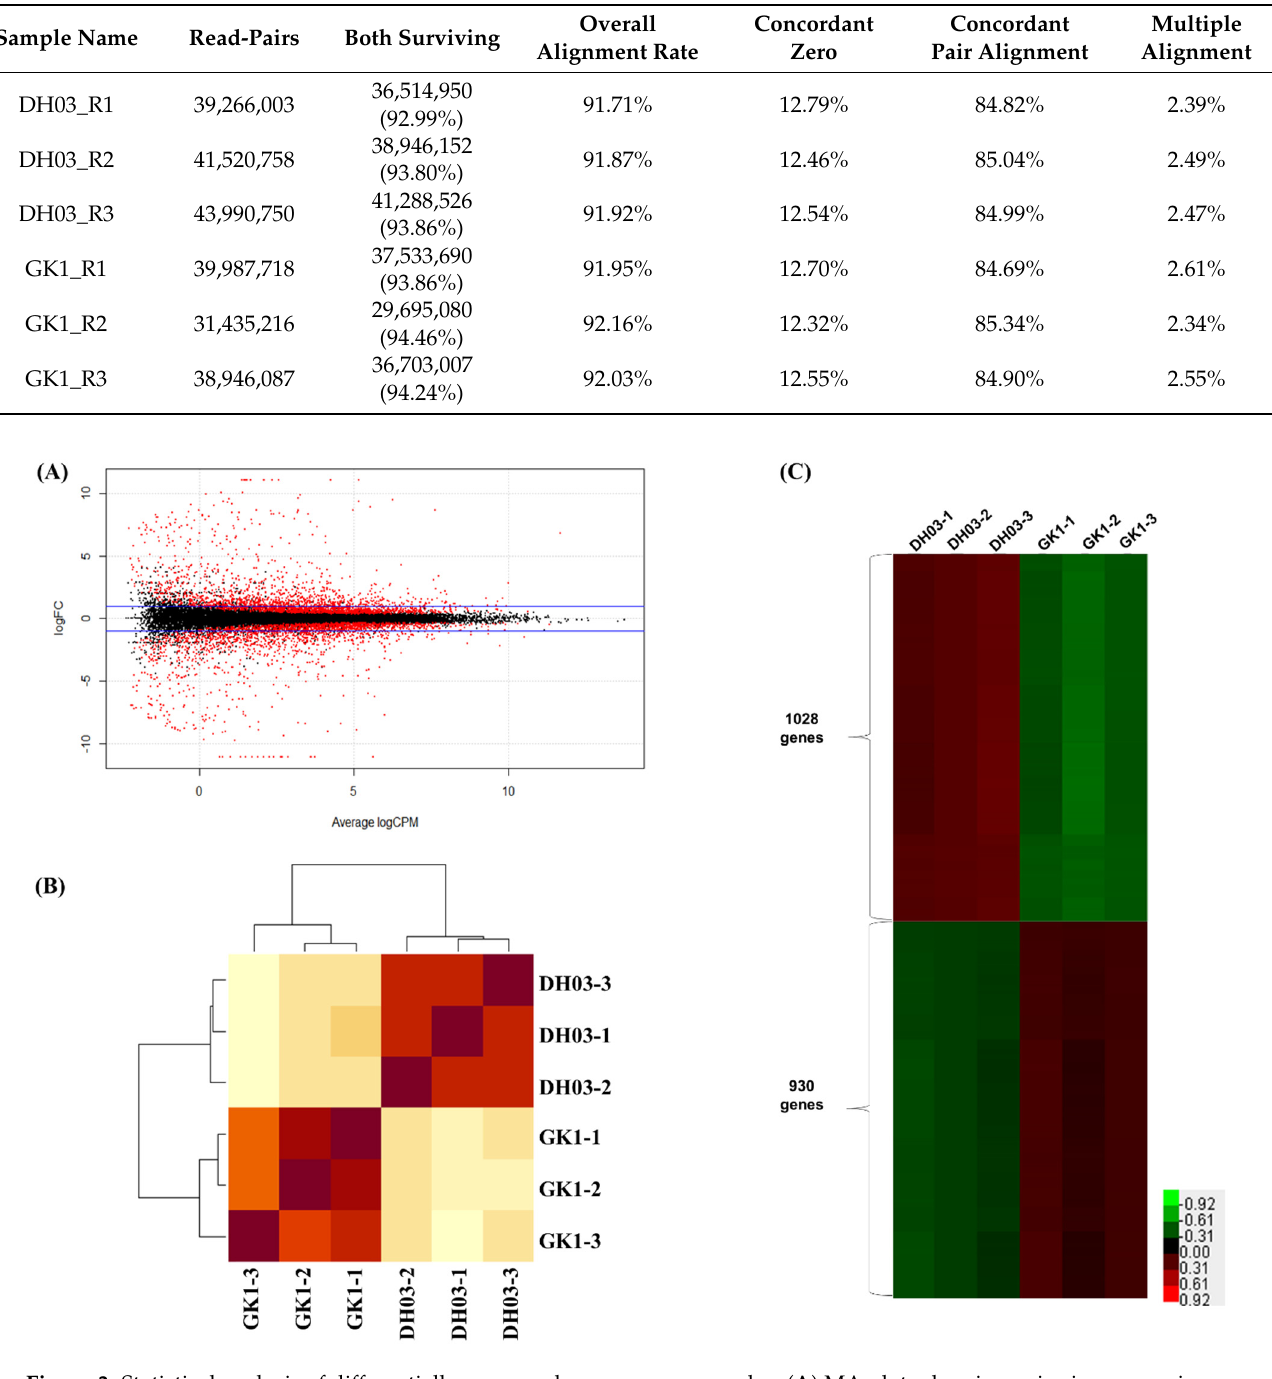
Figure 3. Statistical analysis of differentially expressed genes across samples. ( A ) MA plots showing pairwise comparisons of transcript levels between DH03 and GK1. Y -axis: log2 fold change (logFC) between two samples; X -axis: log2 average count normalized to the size factor. Red dots: transcripts with an absolute log 2 fold change ≥ 1; black dots: transcripts with an absolute log 2 fold change < 1. ( B ) Clustered heatmap showing the Pearson correlation matrix for pairwise sample comparisons. The color key was adjusted based on the log2-centered values to show differences. Dendrograms show distances between repeat samples. ( C ) Number of significantly expressed genes (FDR p < 0.05) between DH03 and GK1. A total of 1028 downregulated and 930 upregulated genes in GK1 compared to DH03 are